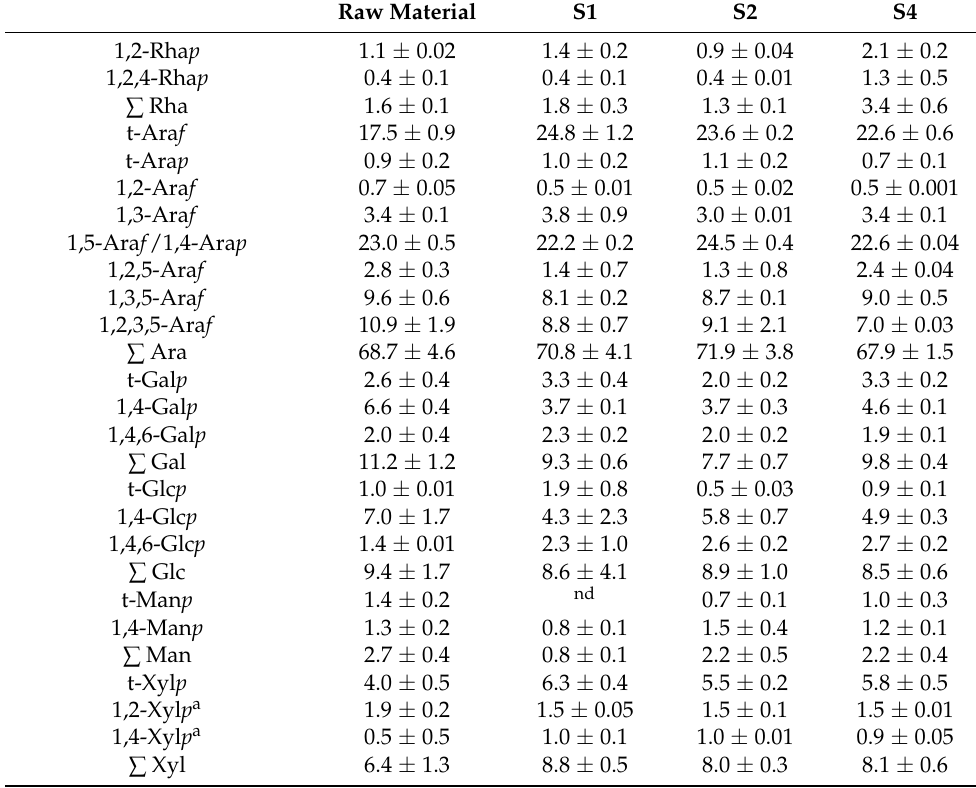
Table A5. Glyosidic linkages of soluble dietary fiber (SDF) polysaccharides of enzymatically treated apple pomace (raw and extruded) (mol%, mean value ± range/2, n = 2). t: terminal, p: pyranose, f: furanose, Rha: rhamnose, Ara: arabinose, Gal: galactose, Glc: glucose, Man: mannose, Xyl: xylose, S1: only transport elements, S2: two reverse elements, S4: two reverse elements and a kneading